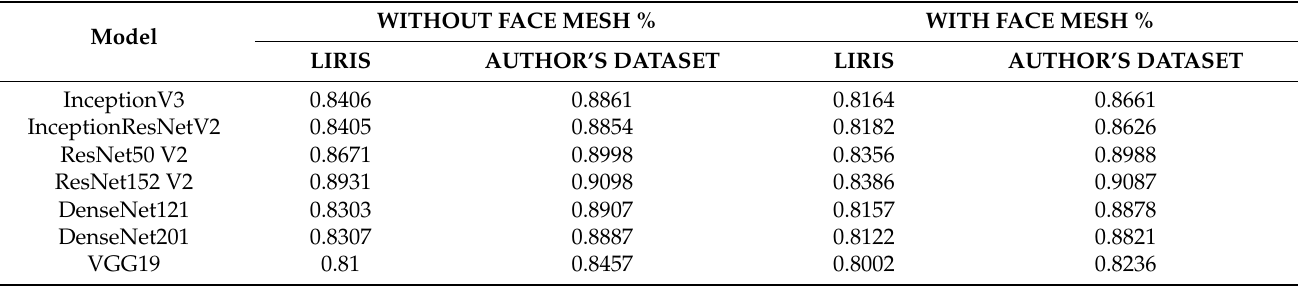
Table 8. Overall comparison of accuracy achieved on all kinds of dataset